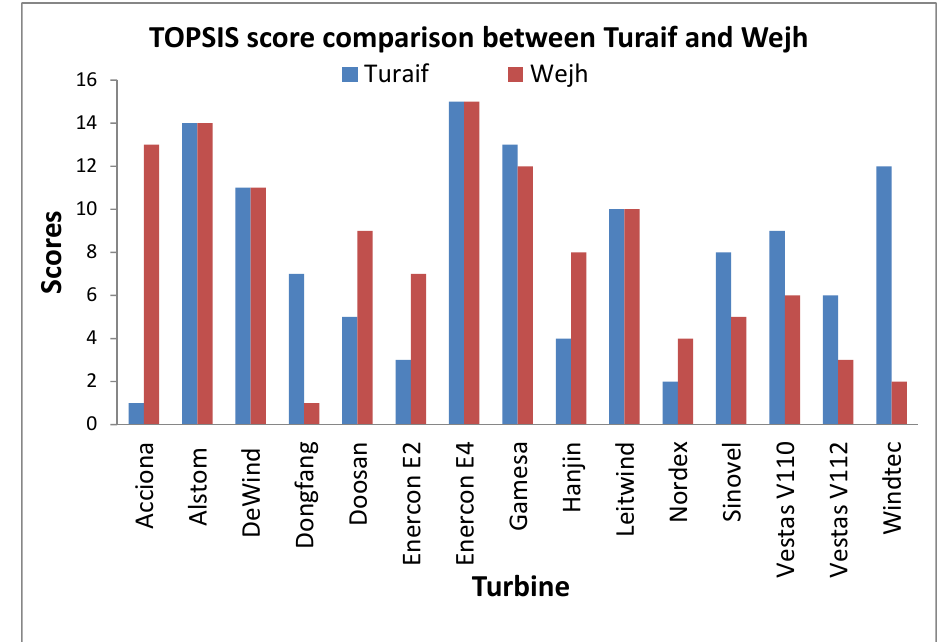
Figure 7. Comparison of scores for different turbines for Turaif and Wejh using TOPSIS.